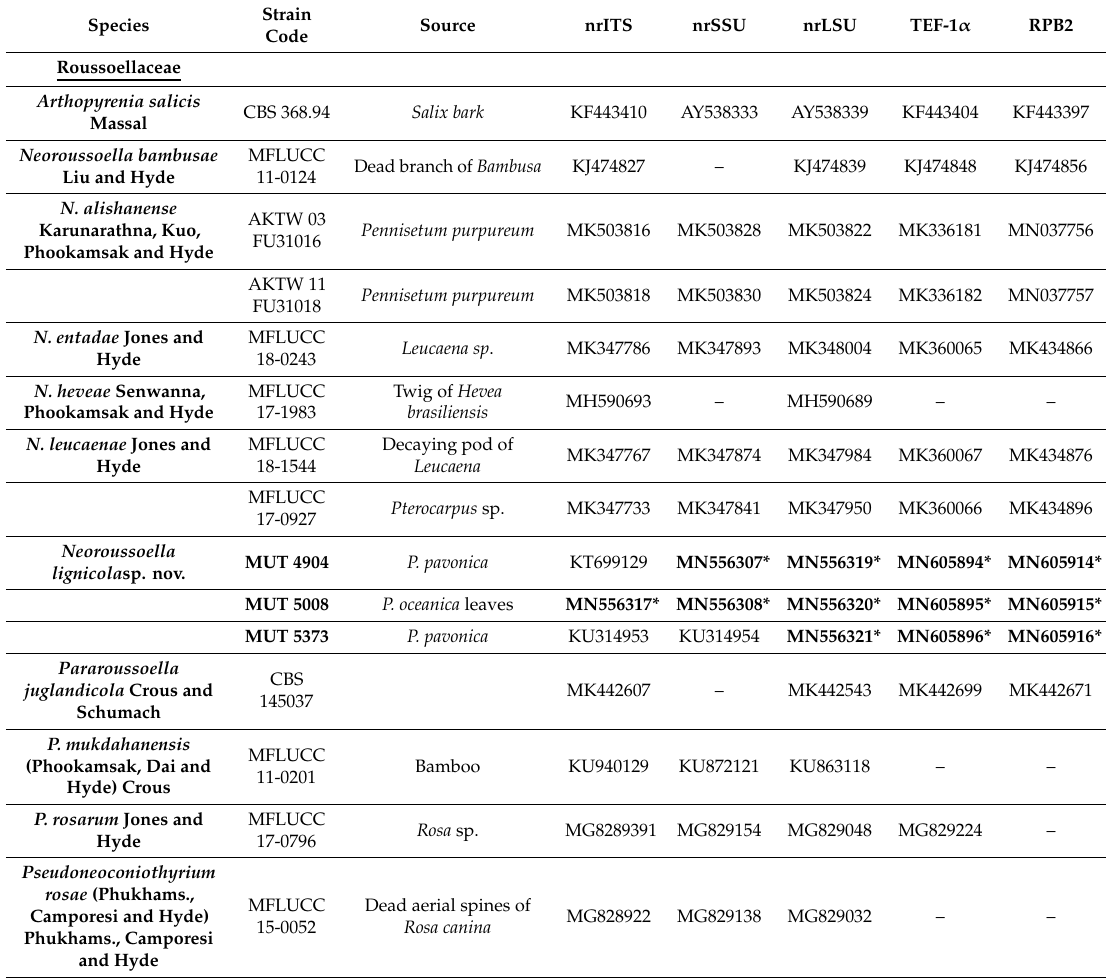
Table 1. Dataset used for phylogenetic analysis. Genbank sequences including newly generated nrITS, nrLSU, nrSSU, TEF1- α and RPB2 amplicons relative to the novel species of Roussoellaceae and Thyridariaceae, to Parathyridaria robiniae MUT 2452 and MUT 4893 and to Parathyridaria ramulicola MUT